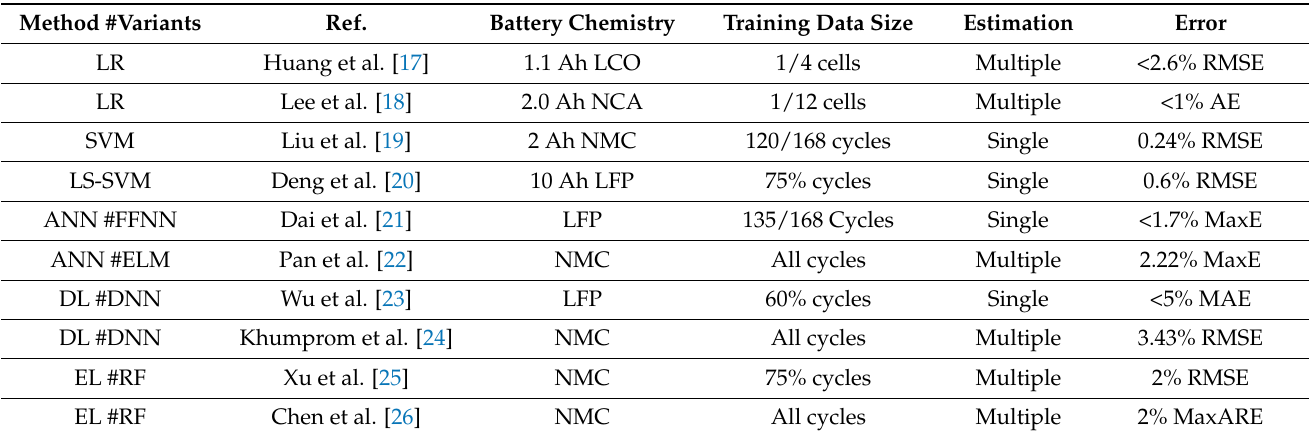
Table 1. A comparison of several machine learning methods for estimating SOH.